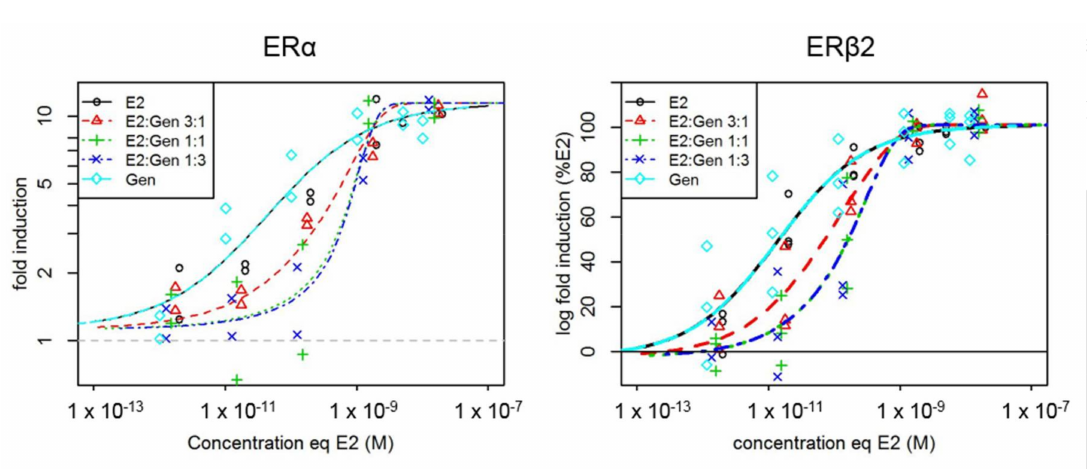
Figure 1. Concentration-response curves of luciferase activity in U251-MG cells transfected with ER α or ER β 2 after exposure to estradiol (E2) and genistein (GEN) alone or in combinations (three different ratios of substances). These data originated from 2 (ER α ) or 3 (ER β 2) independent experiments. All the data were modeled by the dose-level dependent interaction model (DL). Each point represents the mean of triplicated wells. E2 and GEN concentration-response curves are superimposed because the concentration is expressed in E2-equivalents which have been calculated with the EC50s from these curves.